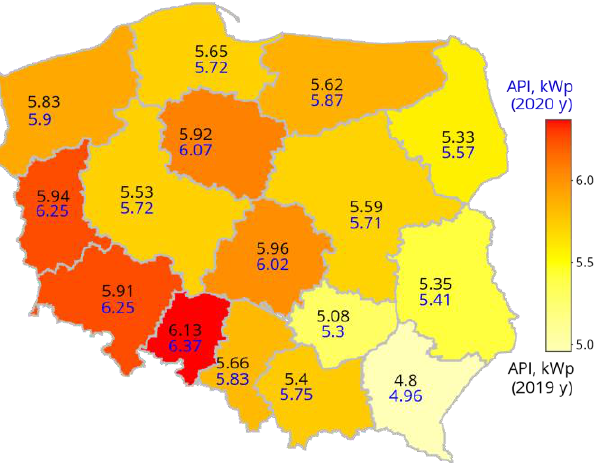
Figure 6. Average installed capacity of installations under the “My Electricity” program (API), in year: 2019 (2019 y),